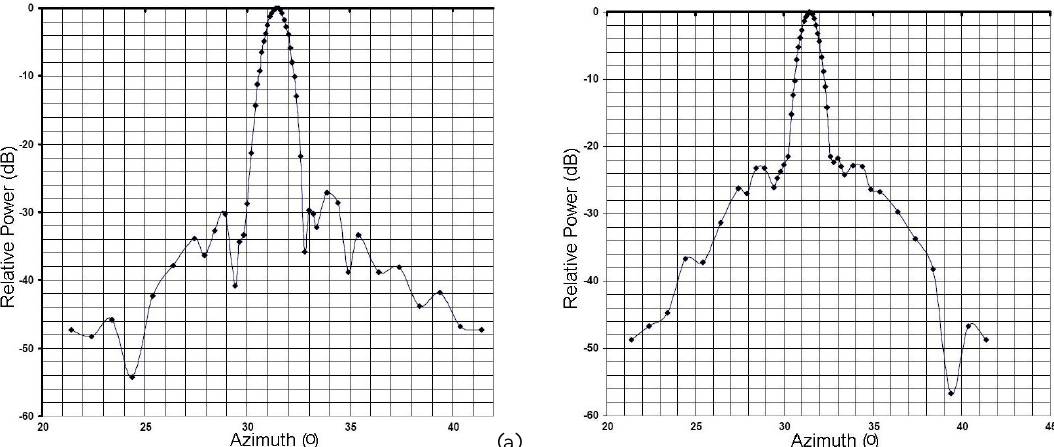
Fig. 2. Antenna diagram of the MXPOL transmission and reception of azimuthal scanning of horizontal (a) and vertical (b) polarizations.